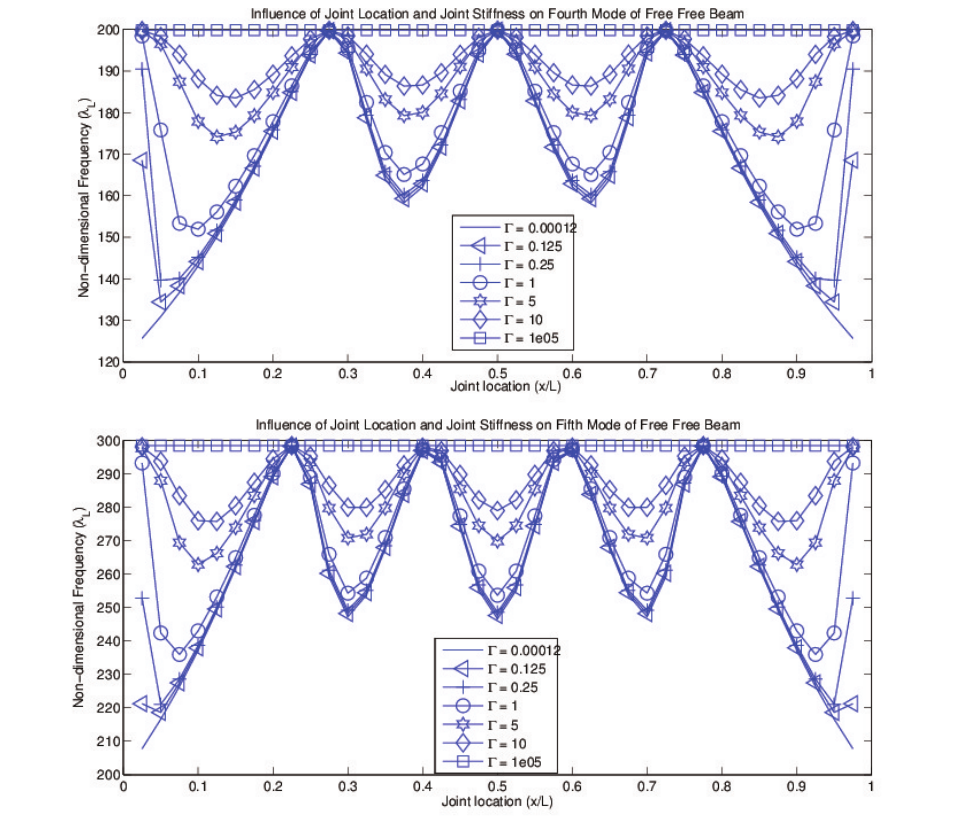
Fig. 3. Influence of joint Location as well as joint stiffness on vibration modes (Mode4 and Mode5) of uniform free-free